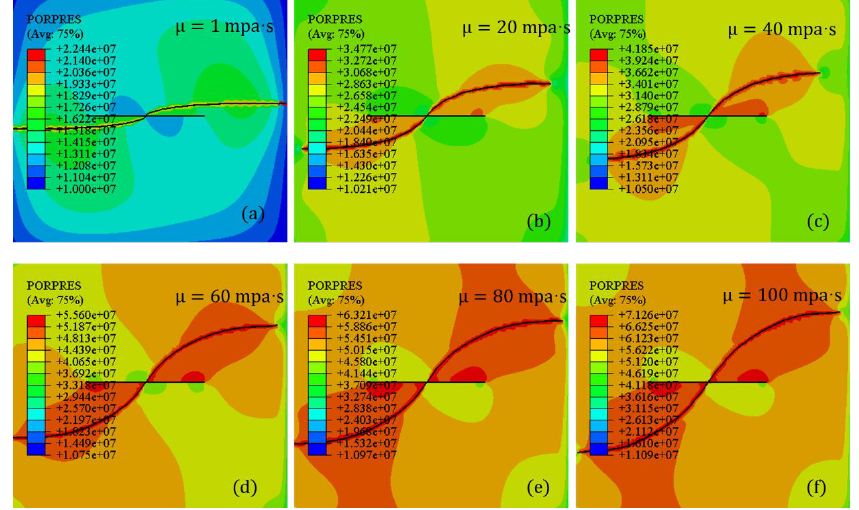
Figure 13. Reorientation behavior of refracturing fractures with different fluid viscosity (PORPRES present the pore-pressure with enrichments: unit is Pa).